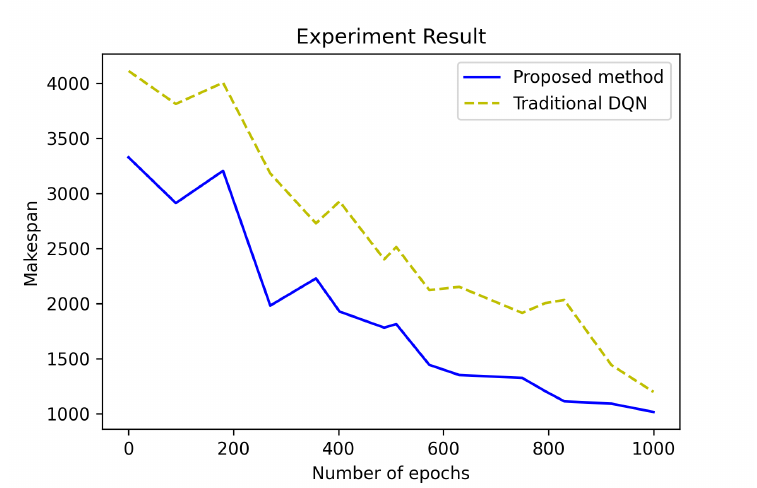
Figure 7. Comparison of the proposed method (DQN with transfer learning) with the existing DQN.